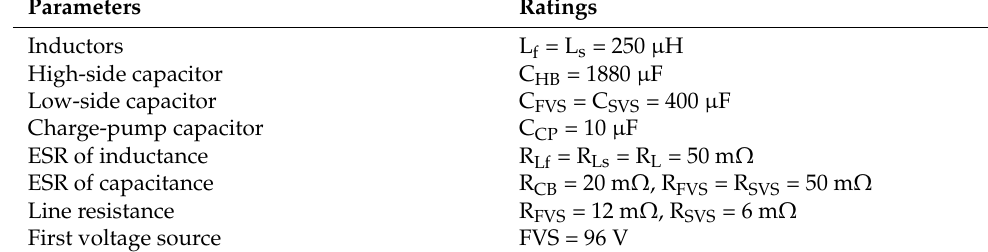
Table 2. Parameters and ratings of the HEV system.